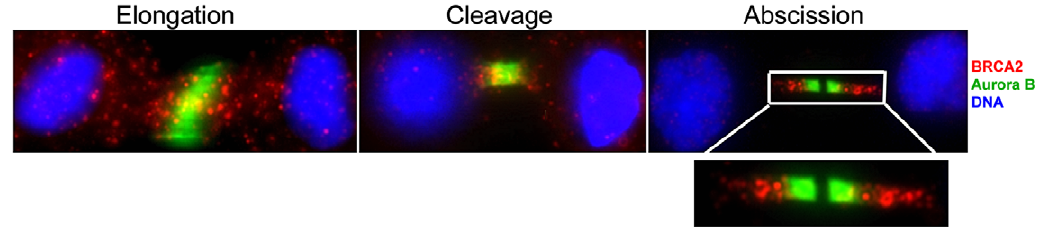
Fig. 4. Representative images of unmodified primary human fibroblasts after immunofluorescence staining to detect BRCA2 and Aurora B. Localization of the BRCA2 protein was investigated in cells in cytokinesis using polyclonal rabbit anti-BRCA2 (red) and monoclonal mouse anti-Aurora B (green) antibodies and DAPI (blue). In early steps of cytokinesis (elongation) little amount of BRCA2 is present between the form- ing daughter cells and mainly dispersed through out the nucleus. As the process proceeds, from elongation to cleavage phase, the accumulation of BRCA2 to the midbody increases and concentrates adjacent to the Aurora B kinase in the abscission phase as indicated by